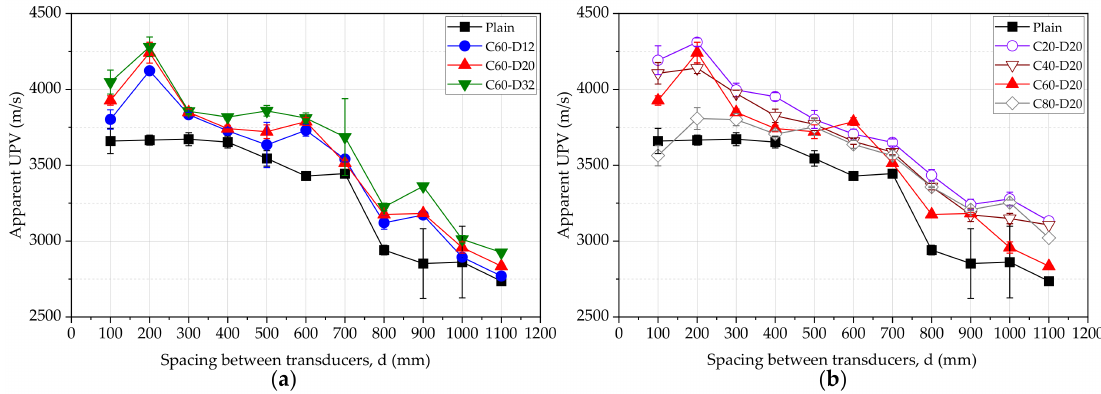
Figure 5. UPV of beams, ( a ) varying bar diameter, ( b ) varying cover thickness.